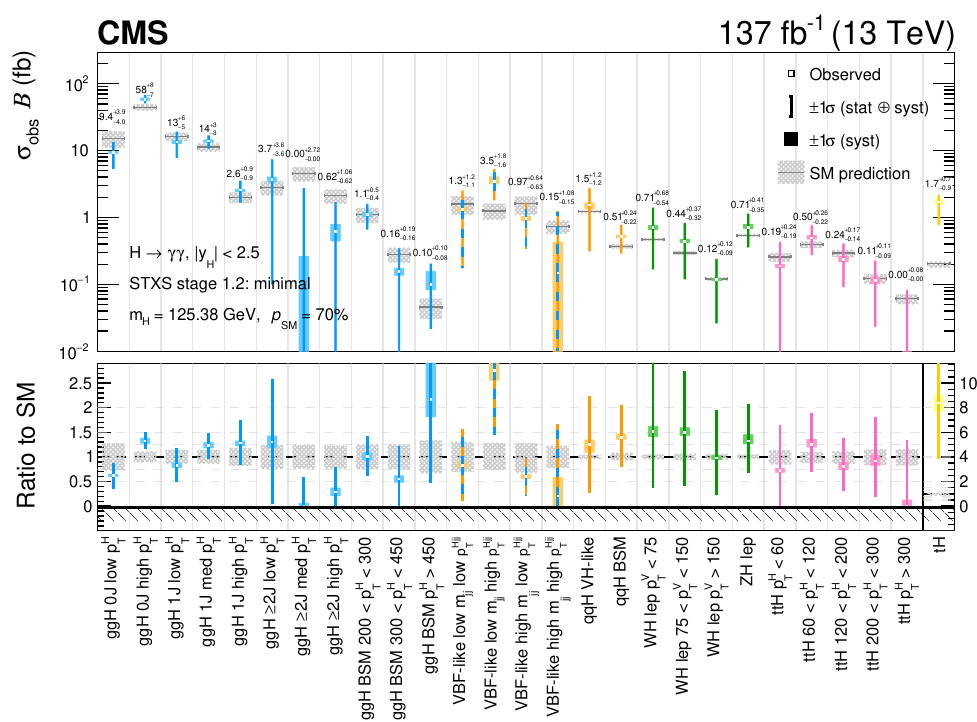
Figure 20 . Observed results of the minimal merging scheme STXS fit. The best fit cross sections are plotted together with the respective 68% CL intervals. The systematic components of the un- certainty in each parameter are shown by the coloured boxes. The hatched grey boxes demonstrate the theoretical uncertainties in the SM predictions. The lower panel shows the ratio of the fitted values to the SM predictions. Here the tH cross section ratio has a different scale, due to its high best fit value and uncertainty. The cross sections are constrained to be non-negative, as indicated by the hashed pattern below zero. The parameters whose best fit values are at zero are known to have 68% CL intervals which slightly under-cover; this is checked to be a small effect using pseudo- experiments. The colour scheme is chosen to match the diagram presented in figure 1. The orange lines dashed with blue for the VBF-like parameters represent contributions from both the ggH and the qqH STXS bins. The compatibility of this fit with respect to the SM prediction, expressed as a p -value, is approximately